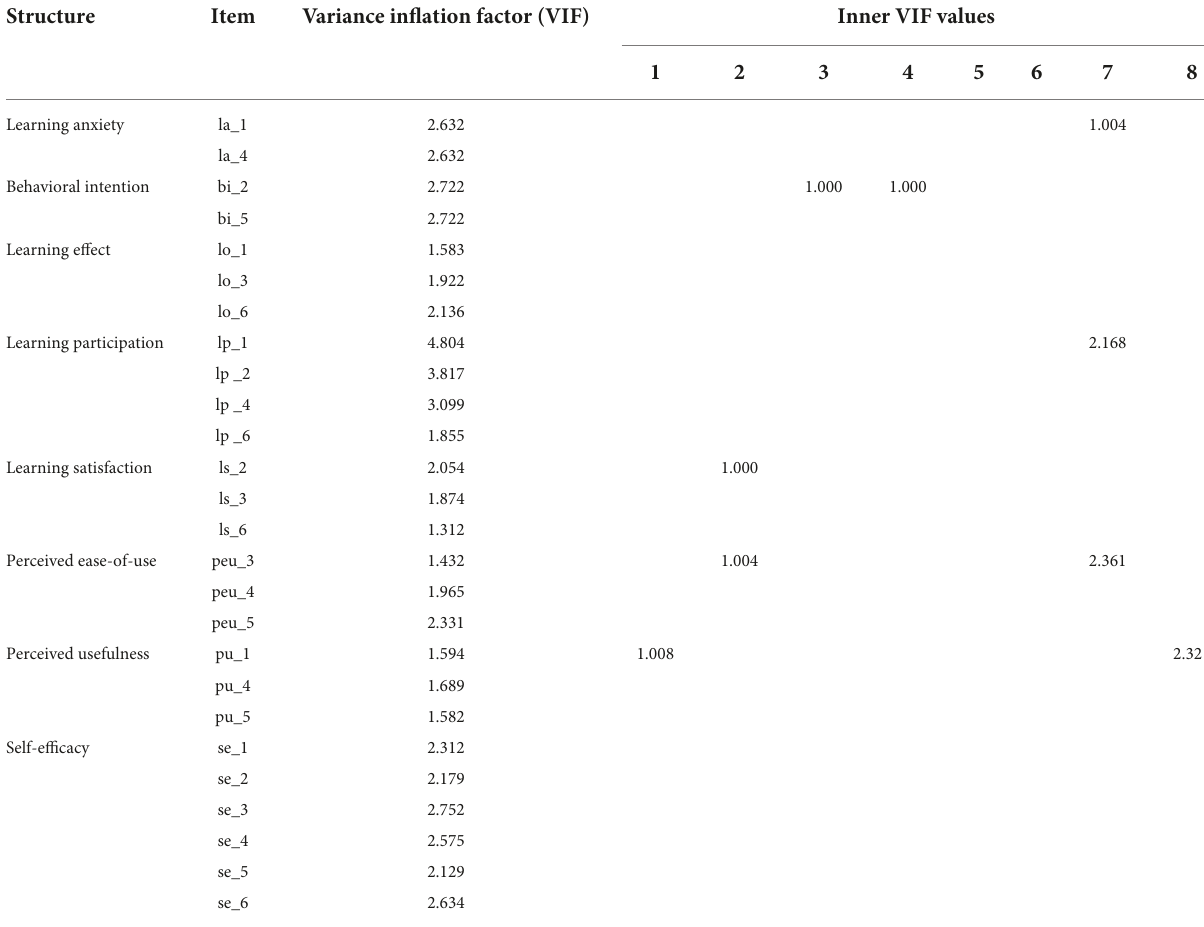
TABLE 6 SPOC-AIoT scaling structure model VIF verification table. Structure